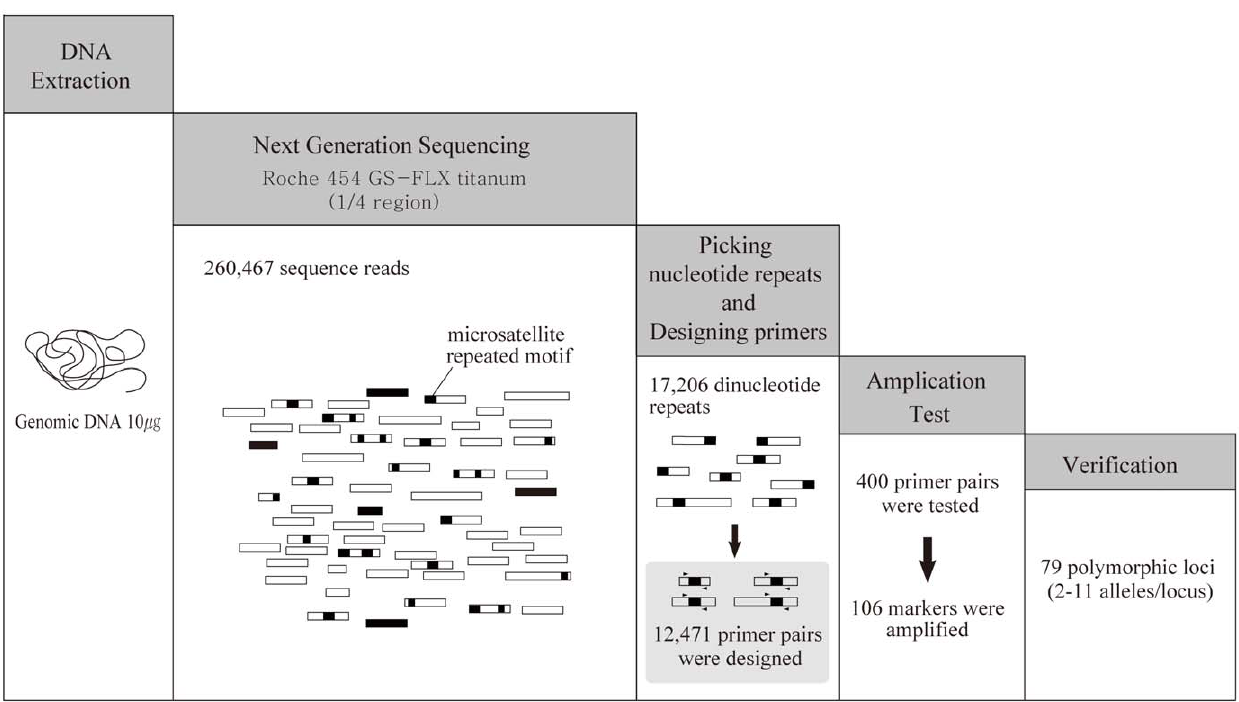
Figure 3. Diagrammatical representation of the NGS method of microsatellite isolation.